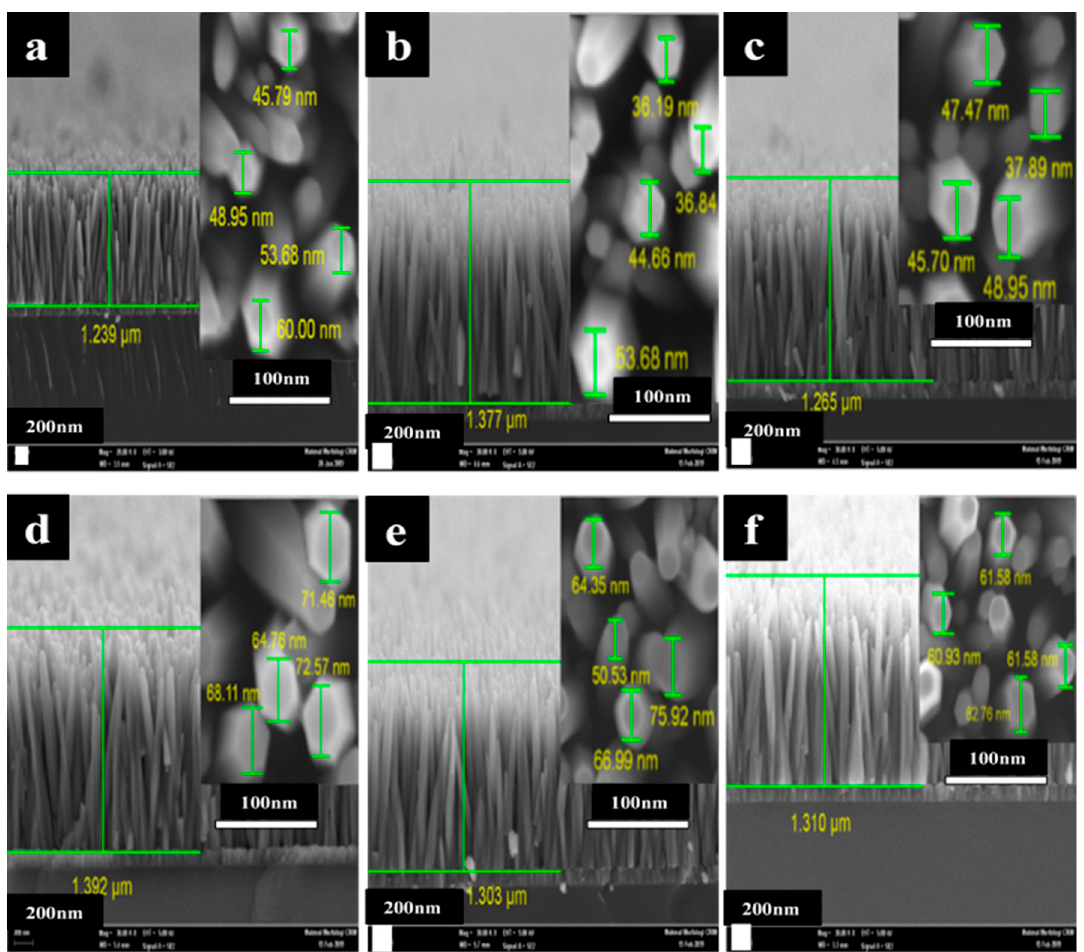
Figure 2. The FE-SEM cross section images of the ZnO nanorods doped with different concentrations of Mg: ( a ) undoped ZnO, ( b ) 1%, ( c ) 2%, ( d ) 3%, ( e ) 4%, and ( f ) 5%. The inset shows the surface view (the rod diameter). Table 2. The EDX spectra results of the undoped ZnO and Mg-doped ZnO samples.